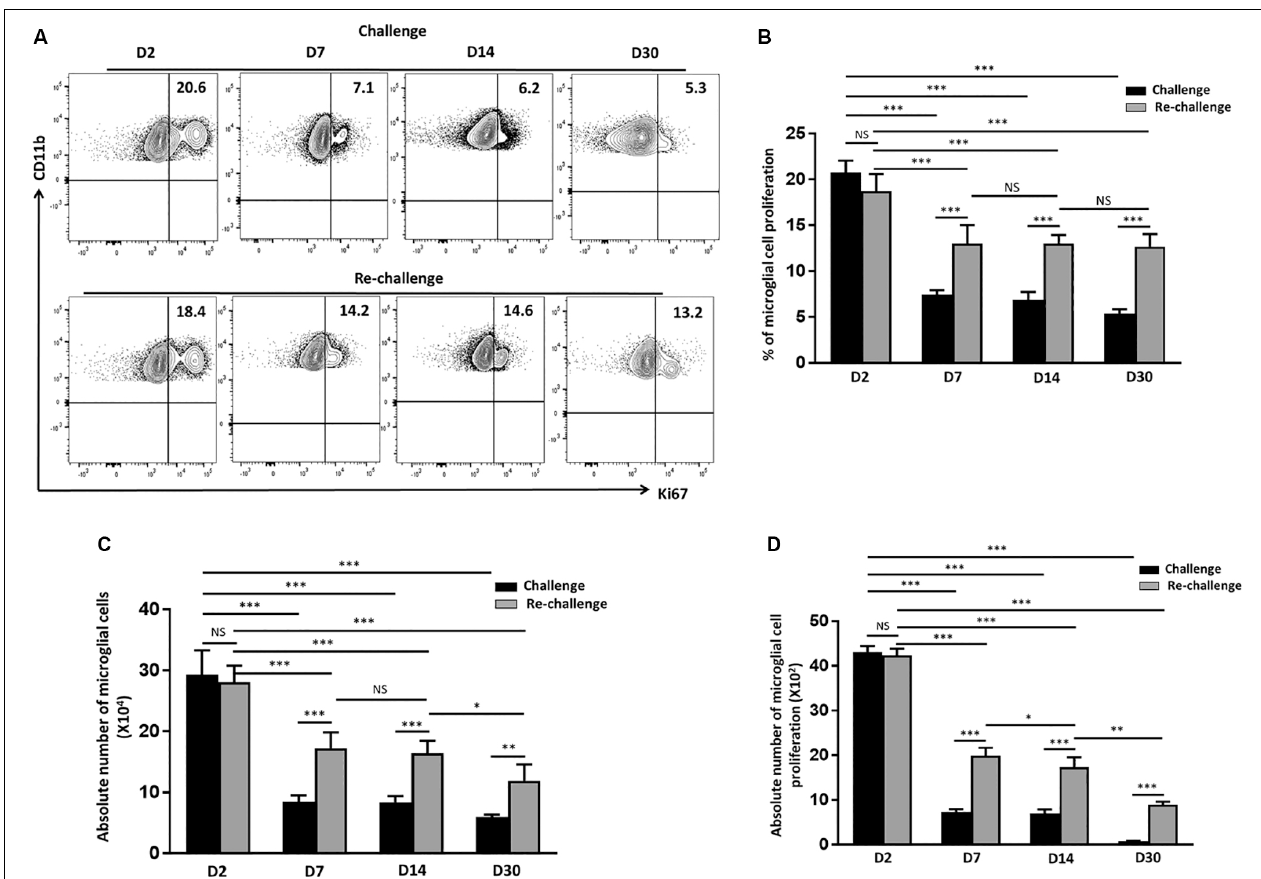
FIGURE 3 | In vivo peptide re-challenge resulted in sustained microglial cell proliferation. (A) Representative contour plots present the expression of Ki67 on CD45 int /CD11b + microglial cells at d 2, 7, 14, and 30 post-challenge and re-challenge with cognate antigen. (B) Bar graph presents pooled data as a percentage (mean ± SD) of Ki67 expression on the microglial-gated population. (C) Bar graph presents the absolute numbers of microglial cells among challenged and re-challenged groups at d 2, d 7, d 14, and 30. (D) Pooled data show the absolute numbers of proliferating microglia among challenged and re-challenged groups at the indicated time points. Data are derived from two independent experiments using six animals/group/time point (two brains pooled together). ∗ p < 0.05, ∗∗ p < 0.01, ∗∗∗ p < 0.001; non-significant (NS) represent groups with no significant